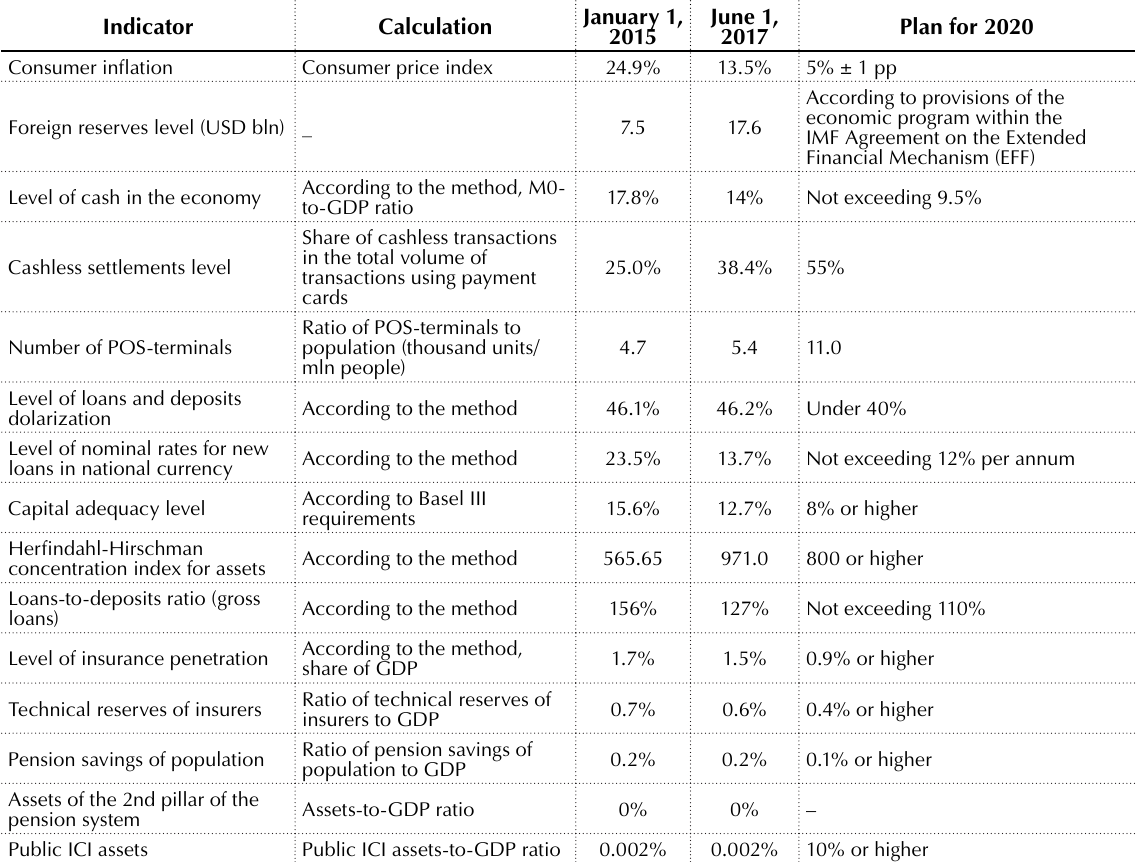
Table 1. Implementation of the Comprehensive Program for the Development of the Financial